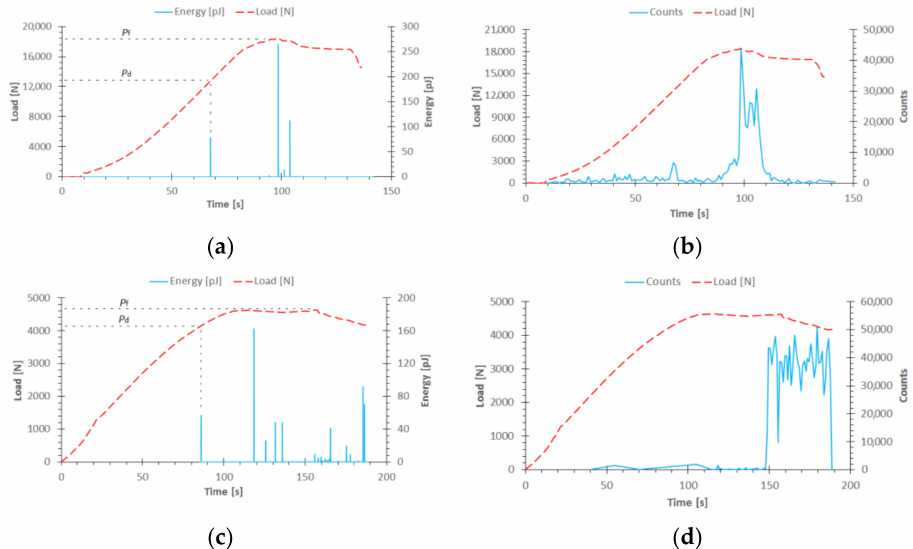
Figure 6. Post-critical equilibrium paths with acoustic emission signals: ( a ) top-hat (energy); ( b ) top- hat (counts); ( c ) channel (energy); ( d ) channel